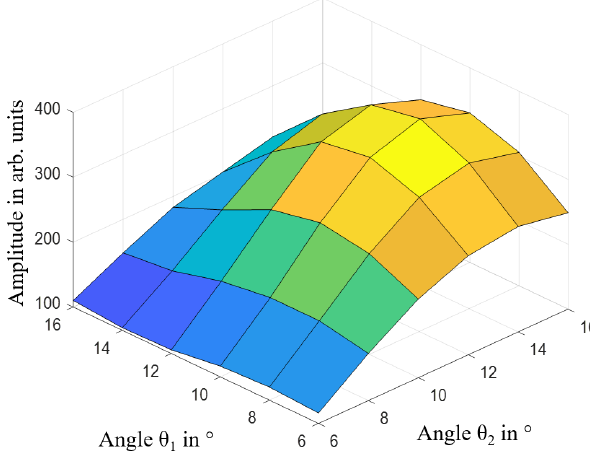
Figure 7. Results of a two-parametric incidence angle